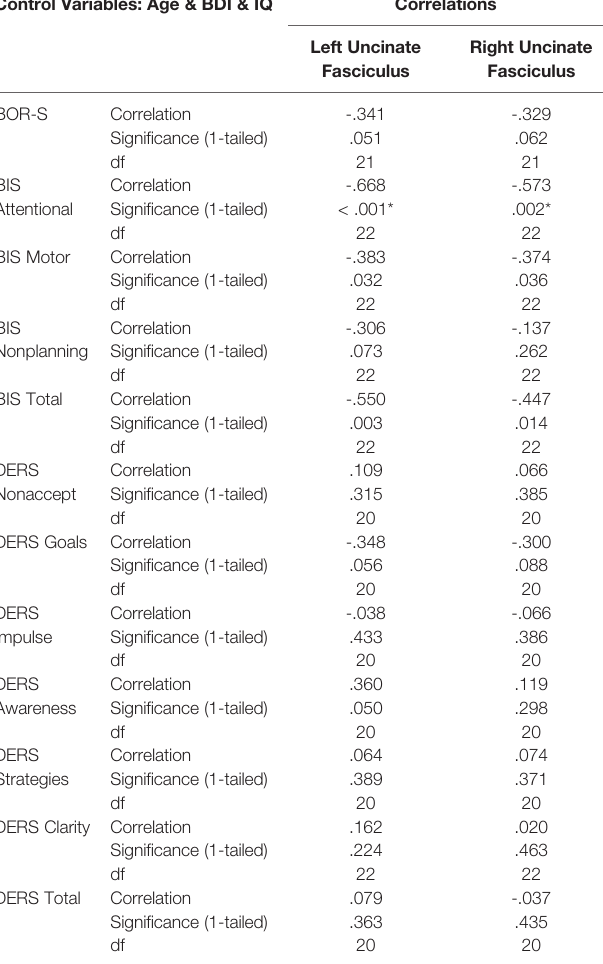
TABLE 2 | Self-regulation and uncinate fasciculus correlations. Control Variables: Age & BDI & IQ